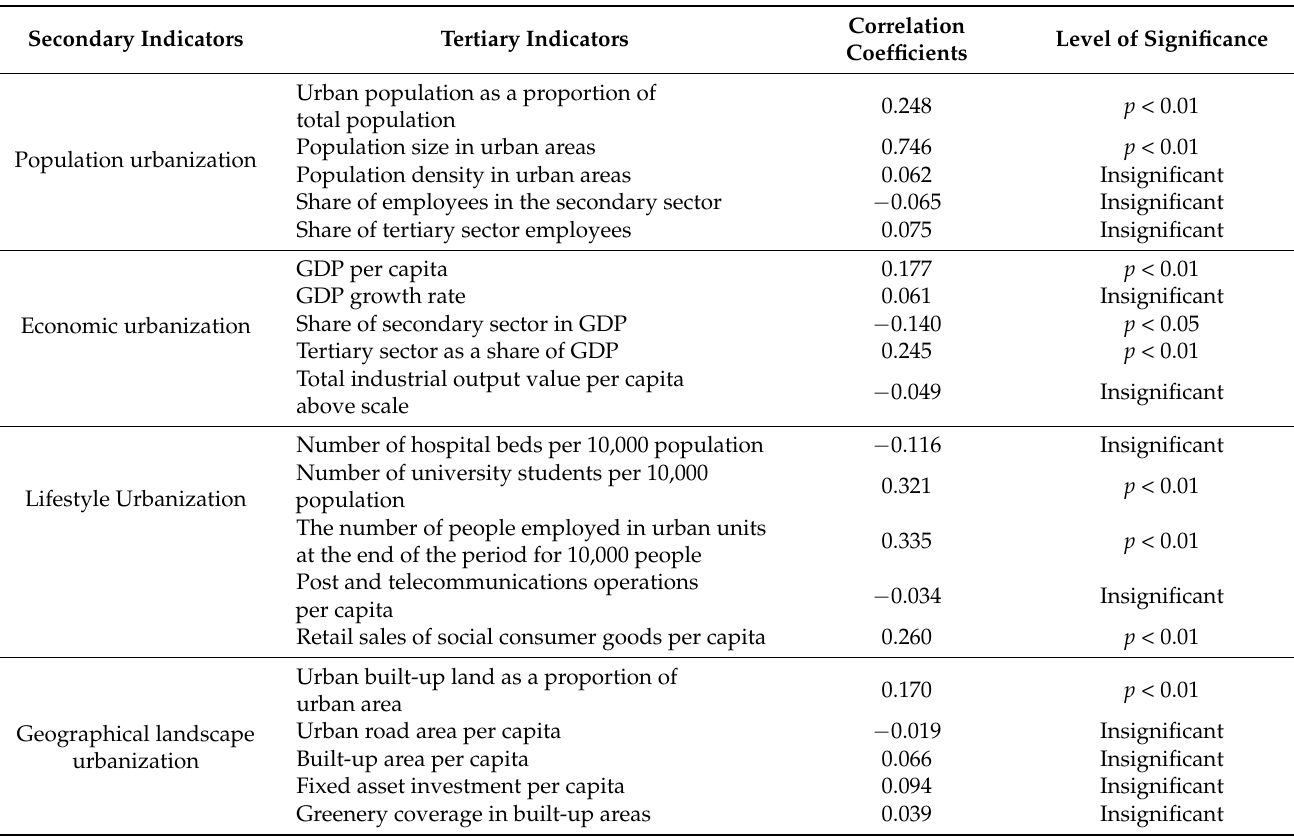
Table 6. Pearson correlation analysis between urban household carbon emissions and urbanization